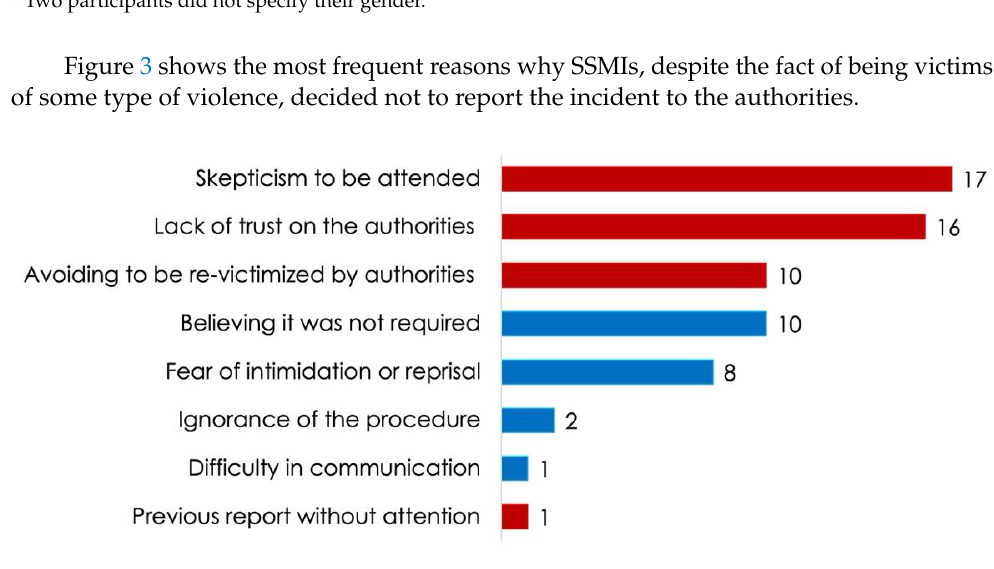
Figure 3. Reasons why social service interns, despite the fact of being victims of violence, do not issue formal reports ( n = 66). Causes attributable to authority are grouped in red and unrelated ones in blue.